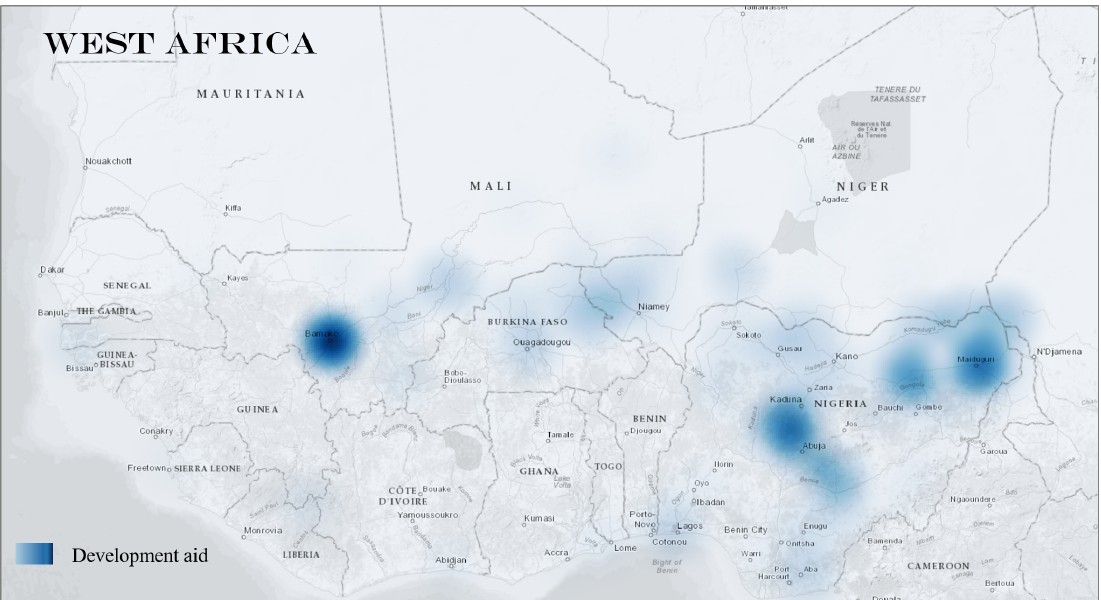
Figure 4. The hotspots of locations mentioned in articles that are mostly concerned with the theme of Development aid .